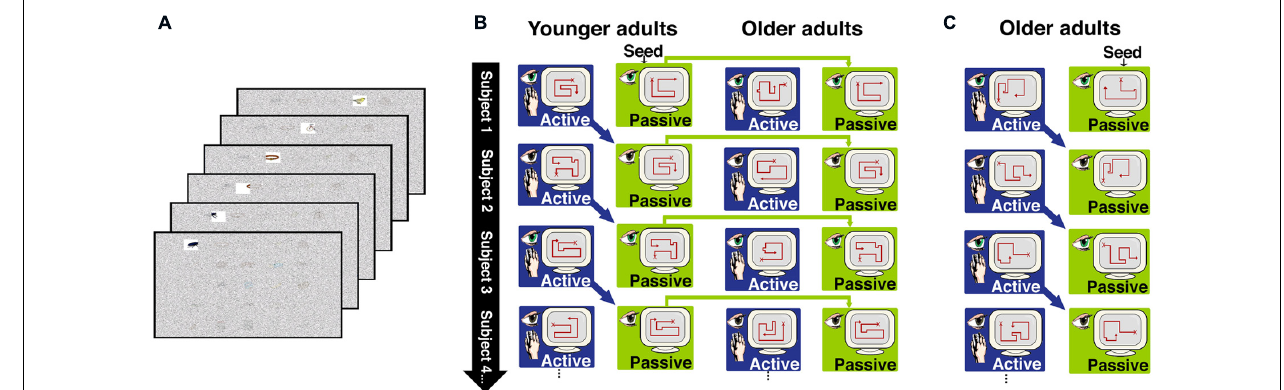
subject and merely watched in the passive learning condition, as described in the text. (B) In Experiment 1, passive window movements were yoked to active window movements within younger subjects, and the passive window movements from younger subjects were also delivered to older subjects. Older and younger subjects controlled window movements in the active condition. (C) In Experiment 2, active and passive window movements were yoked within older subjects